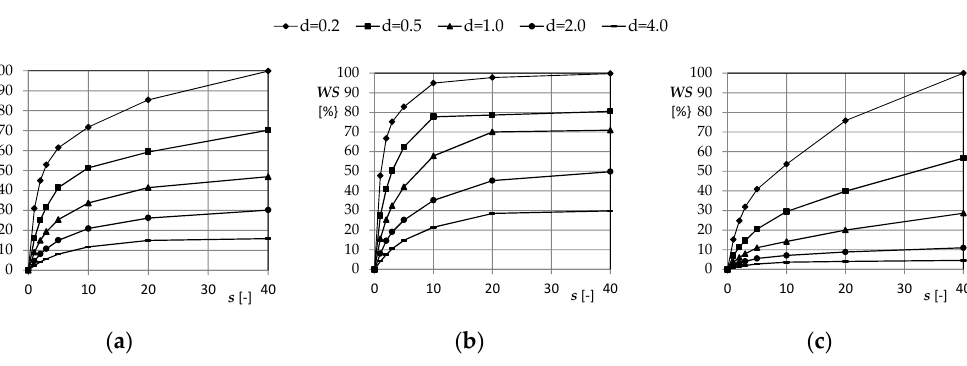
Figure 3. Water saving performance of the RWH system scheme for frequency of exceedance f = 0.9: ( a ) average yearly values; ( b ) average values for the wet season; ( c ) average values for the dry season.